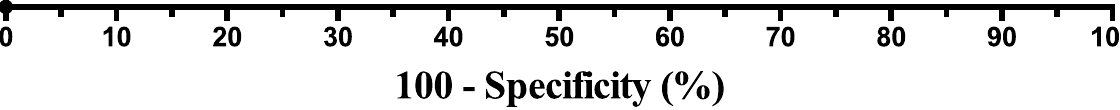
Fig 4. Maternal serum C-reactiveprotein concentrations with respectto the presenceor absence of both MIAC and IAI. A receiver operatingcharacteristic curve for the presenceof both MIAC and IAI (area under the curve is 0.78 for IL-6 cutoff value > 17.5 mg/L; p < 0.0001). Abbreviations: MIAC, microbialinvasionof the amniotic cavity; IAI, intra-amniotic inflammation.